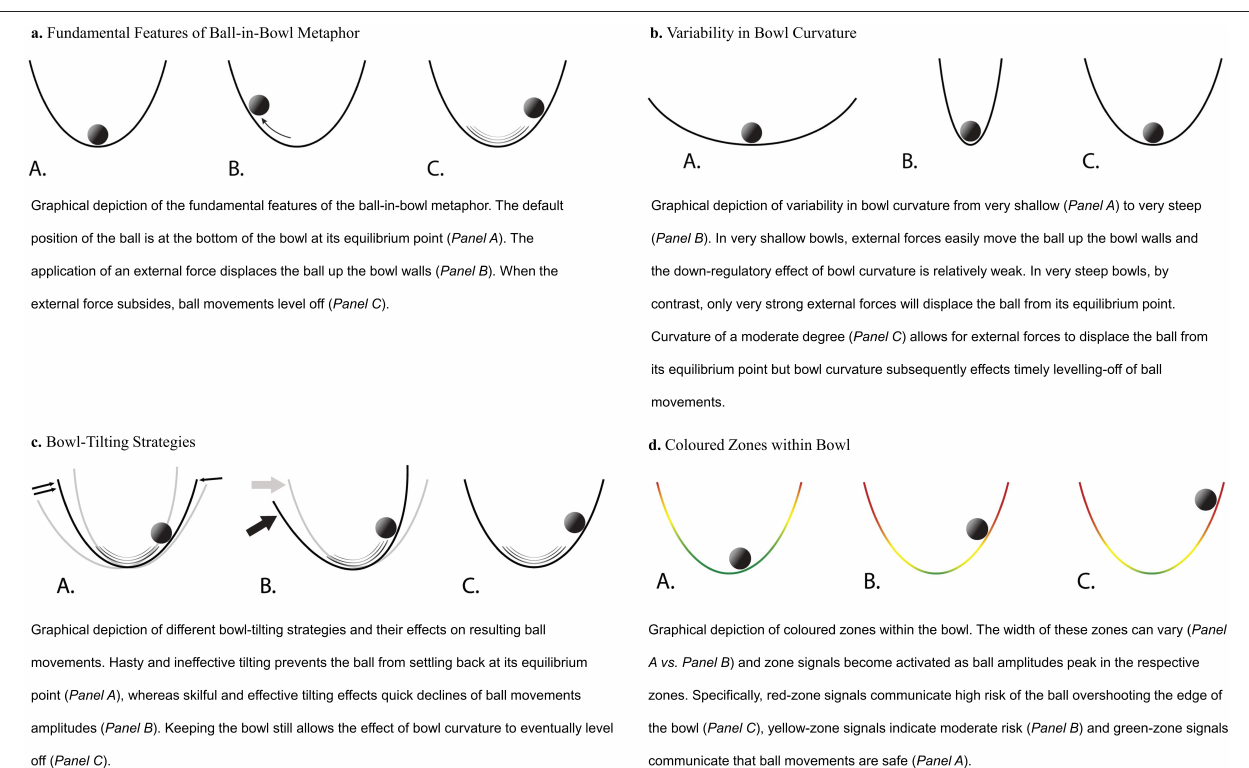
FIGURE 1 | Graphical depictions of the different elements of the bowl-in-bowl metaphor. (a) Fundamental Features of Ball-in-Bowl Metaphor. (b) Variability in Bowl Curvature. (c) Bowl-Tilting Strategies. (d) Colored Zones Within Bowl.